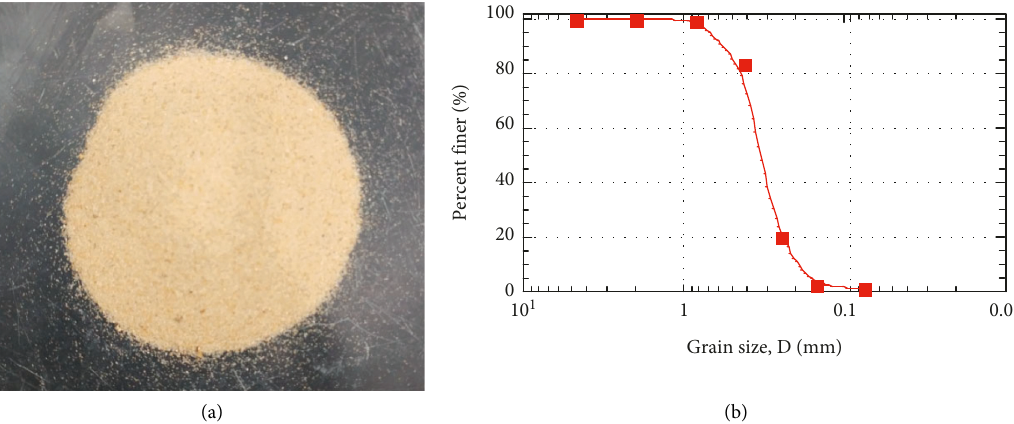
Figure 1: Mississippi local sand used in the experiments: (a) image of sand and (b) particle size distribution curve of the local